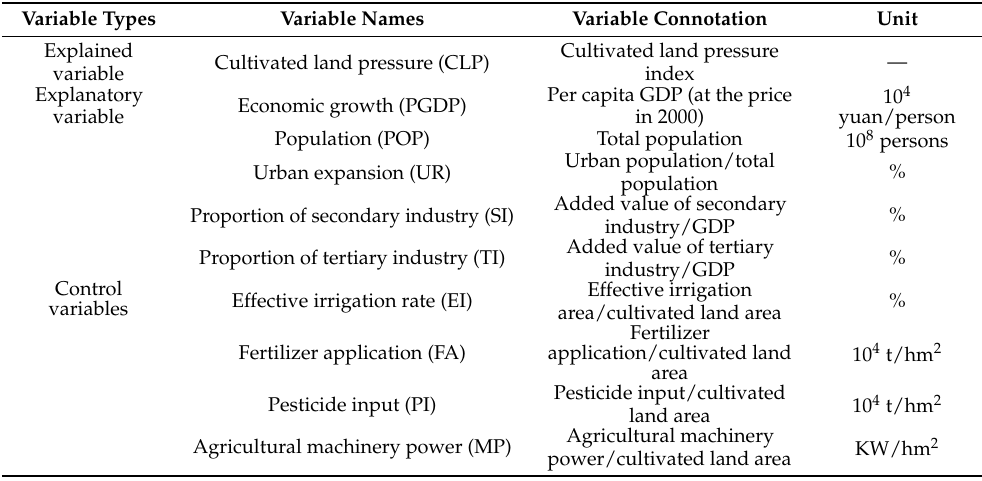
Table 2. Explanation of the variables.